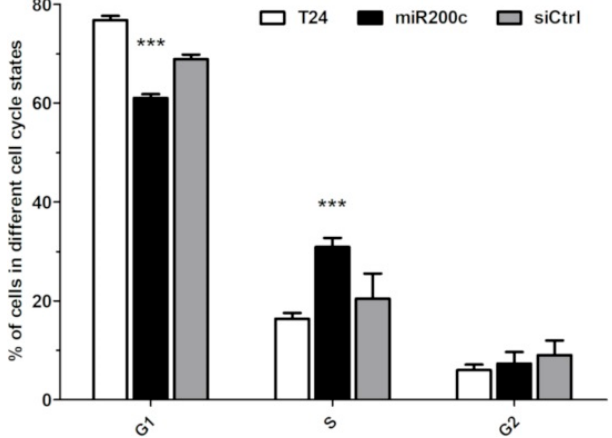
Figure 8. Cell cycle analysis via flow cytometry of cell stages G1, S and G2 of T24 cells at 72 h after treatment. For statistical analysis, a two-tailed t-test was performed ( n = 3, mean ± SD, *** p < 0.01)